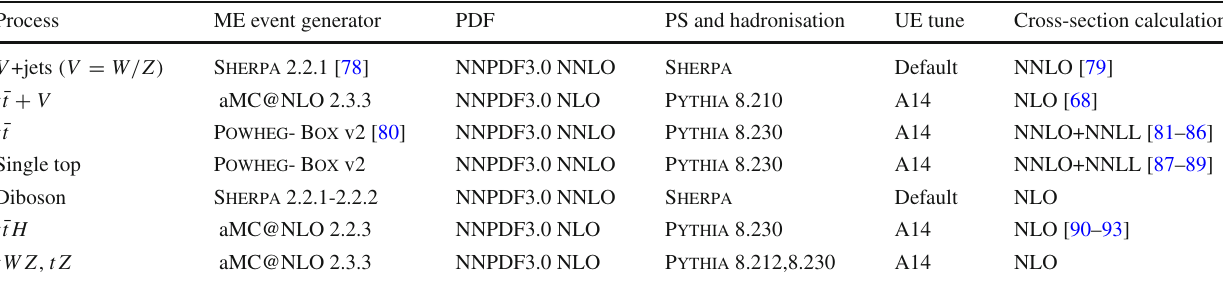
Table 1 Overview of the simulated background